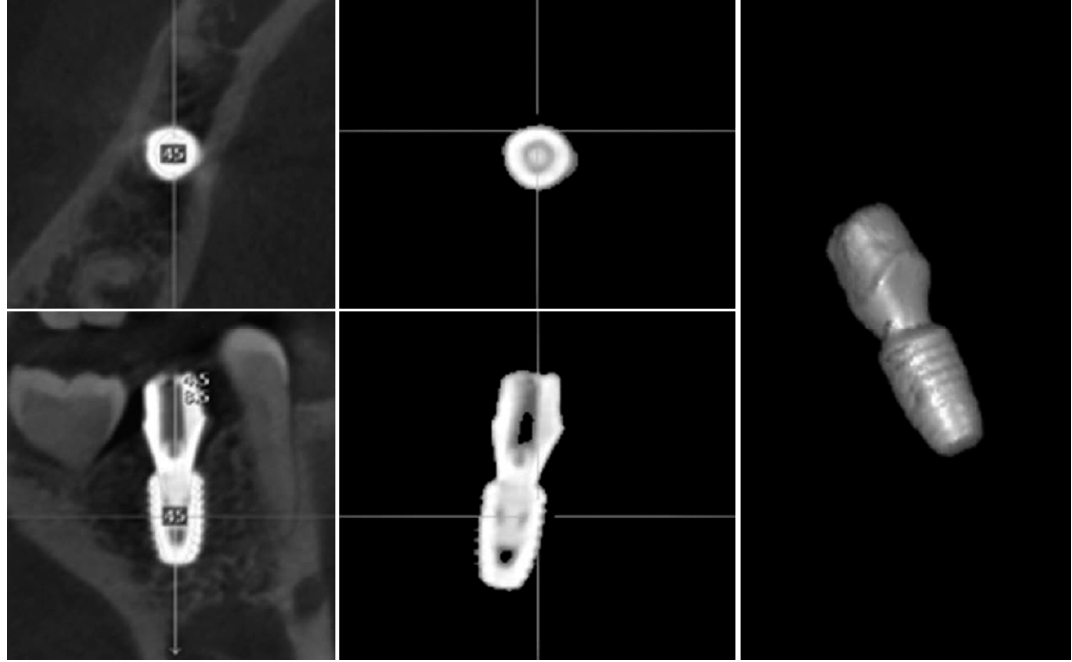
Figure 1. A portion of implant on the post-operative computed topography (CT) is separated. 3D modeling analysis confirms the actual position by directly reproducing the shape of the